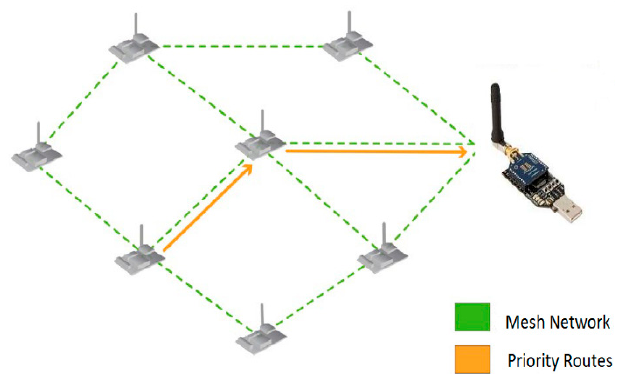
Figure 1. Sensor Network forming mesh.